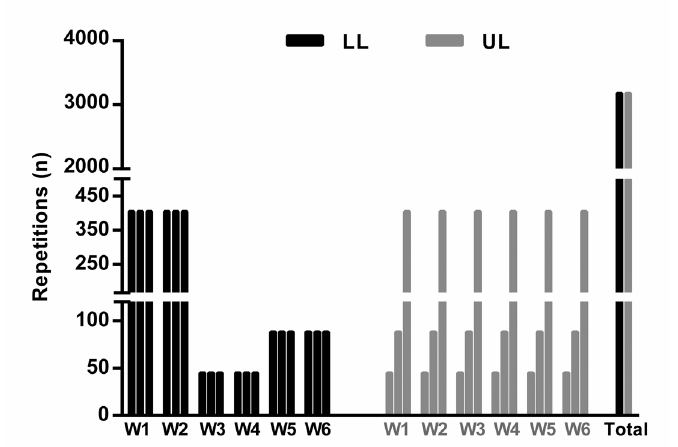
Figure 1. Mean weekly (W) values for number of strength training repetitions in linear load (LL) and undulating load (UL) during the